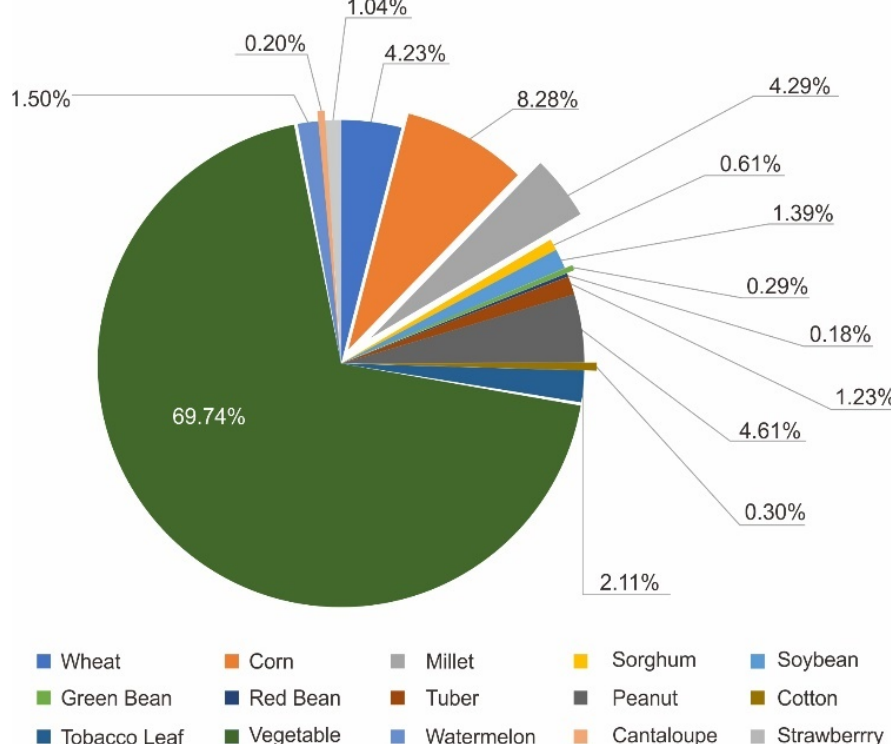
Figure 7. Proportions of product contributing to agriculture carried by cultivated land.